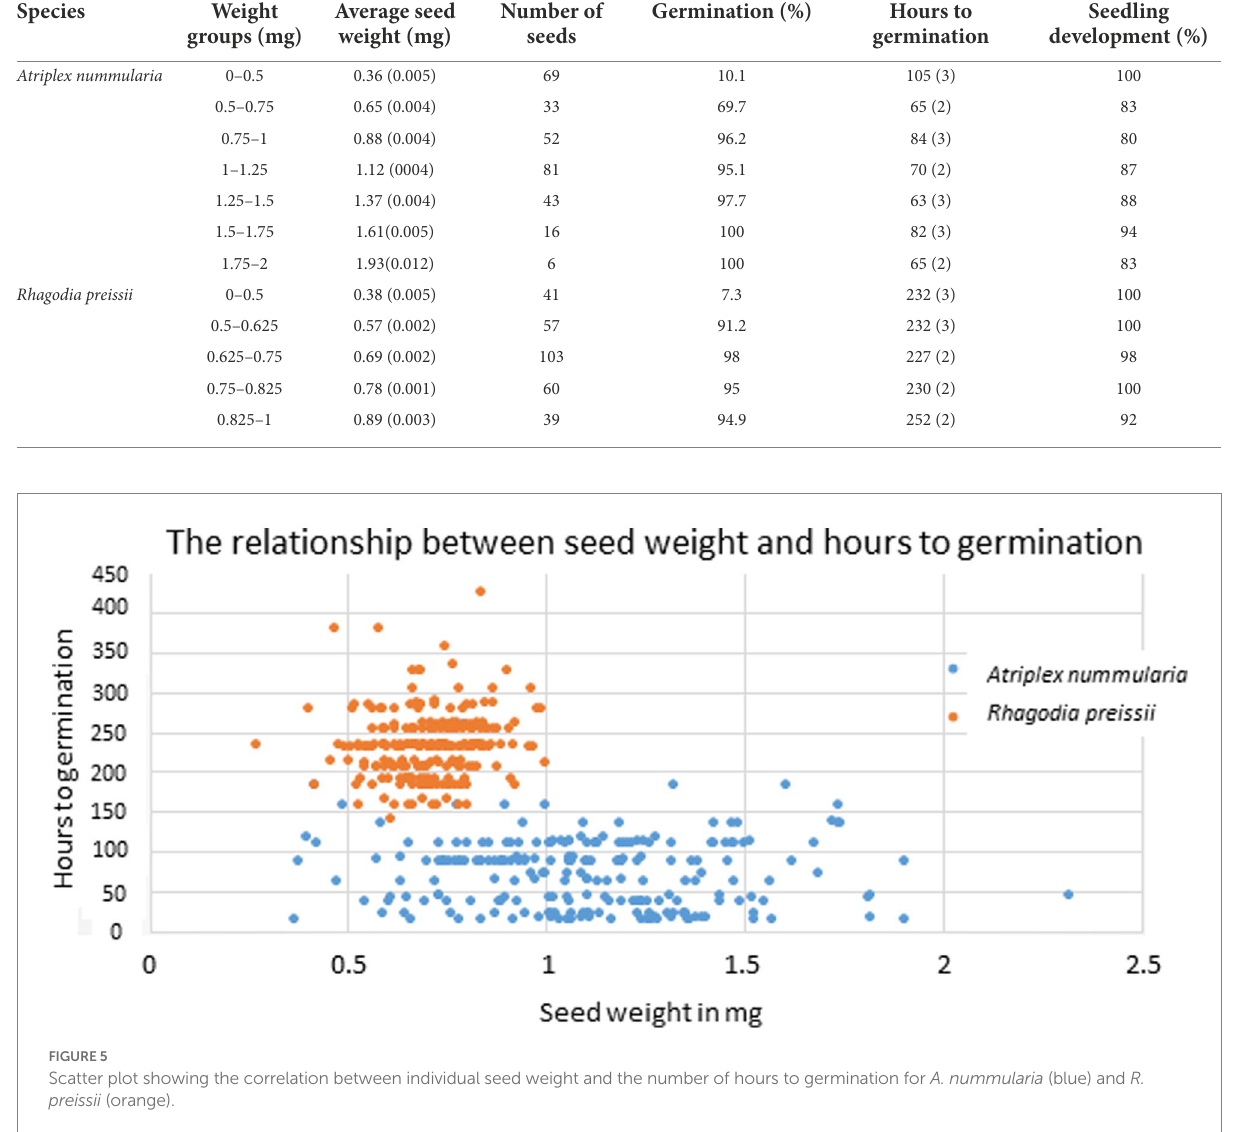
TABLE 6 Germination percentage of individually weighed seeds sorted into weight groups, and the groups average time (hours) to germination and seedling development with standard errors (SE). Species